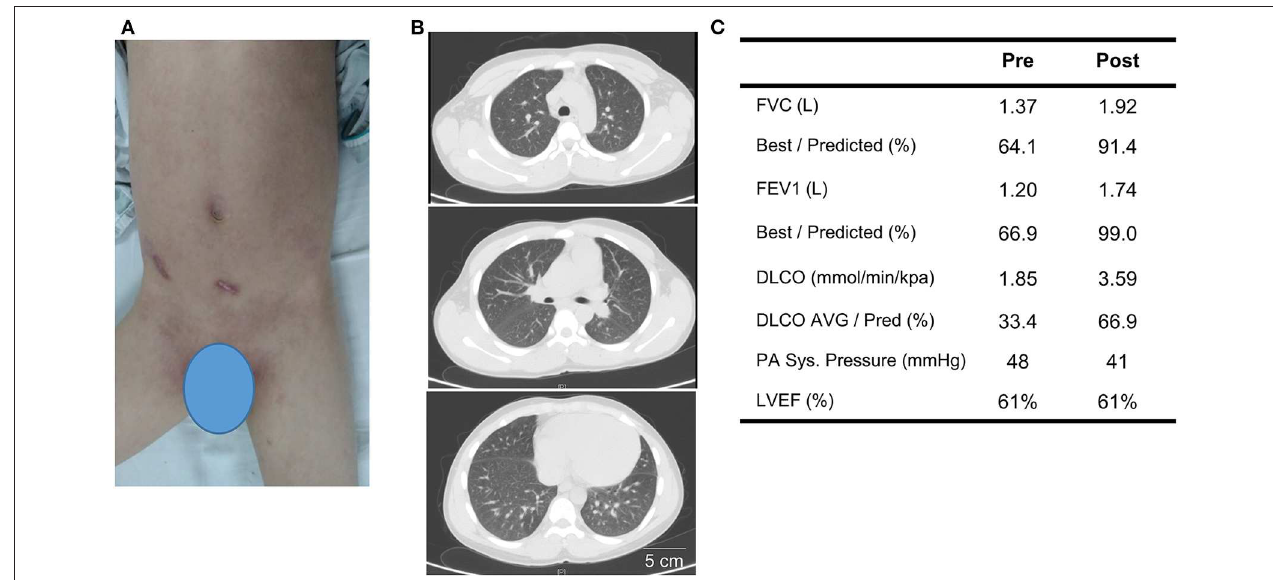
FIGURE 3 | Treatment response to corticosteroids, cyclophosphamide, and tofacitinib after 3 months. (A) Post-treatment image of the skin illustrates resolution of generalized psoriasis in the abdomen and groin. (B) Repeat chest CT shows resolution of pleural effusion and improvement of ground-class opacities. (C) Comparison of key findings from pulmonary function test and echocardiogram pre- and 3 months